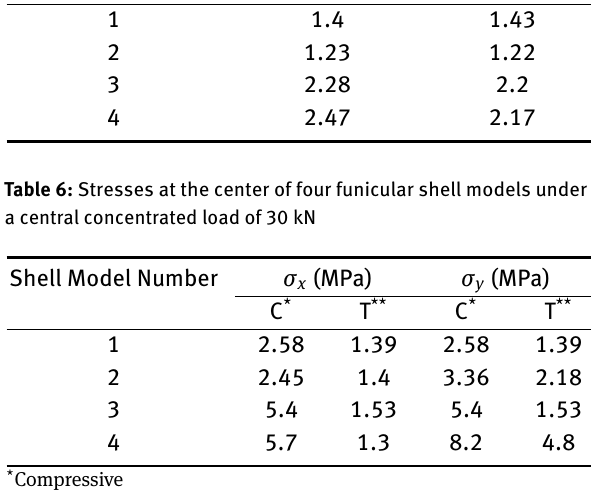
Table 5: Normal displacement at the center of four funicular shell models under a central concentrated load of 30 kN Shell Model Number